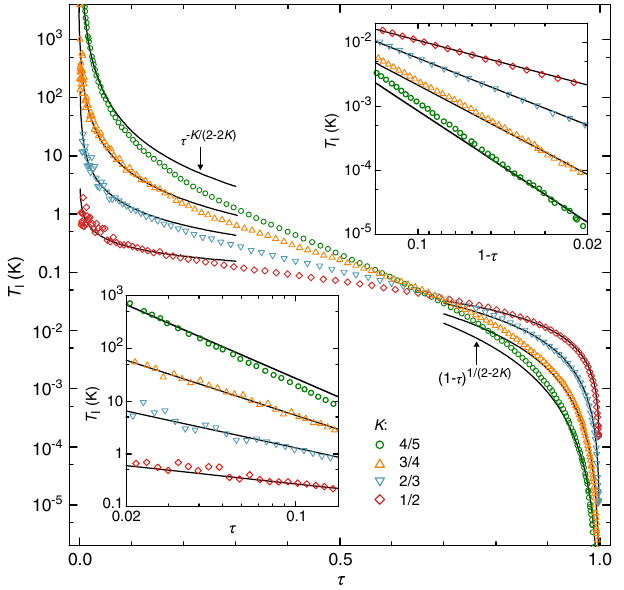
FIG. 3. Scaling temperature versus impurity strength. Sym- bols display the experimentally extracted TLL scaling temper- ature T versus unrenormalized transmission probability I τ ∈ ½ 0 ; 1 (cid:2) . Each set of identical symbols corresponds to the same tuning of the Luttinger interaction parameter K . Con- tinuous lines represent the asymptotic predictions at τ ≪ 1 and 1 − τ ≪ 1 . The fully quantitative K ¼ 1 = 2 prediction is com- pared to the data without any adjustable parameter. At other K ∈ f 2 = 3 ; 3 = 4 ; 4 = 5 g , the unknown multiplicative theoretical factor is freely adjusted. The same data and predictions are also shown in a log-log scale for τ < 0 . 15 (bottom-left inset) and τ > 0 . 85 (top-right